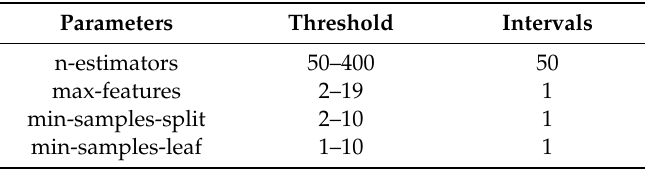
Table 2. Parameters to set for determining the optimal RF